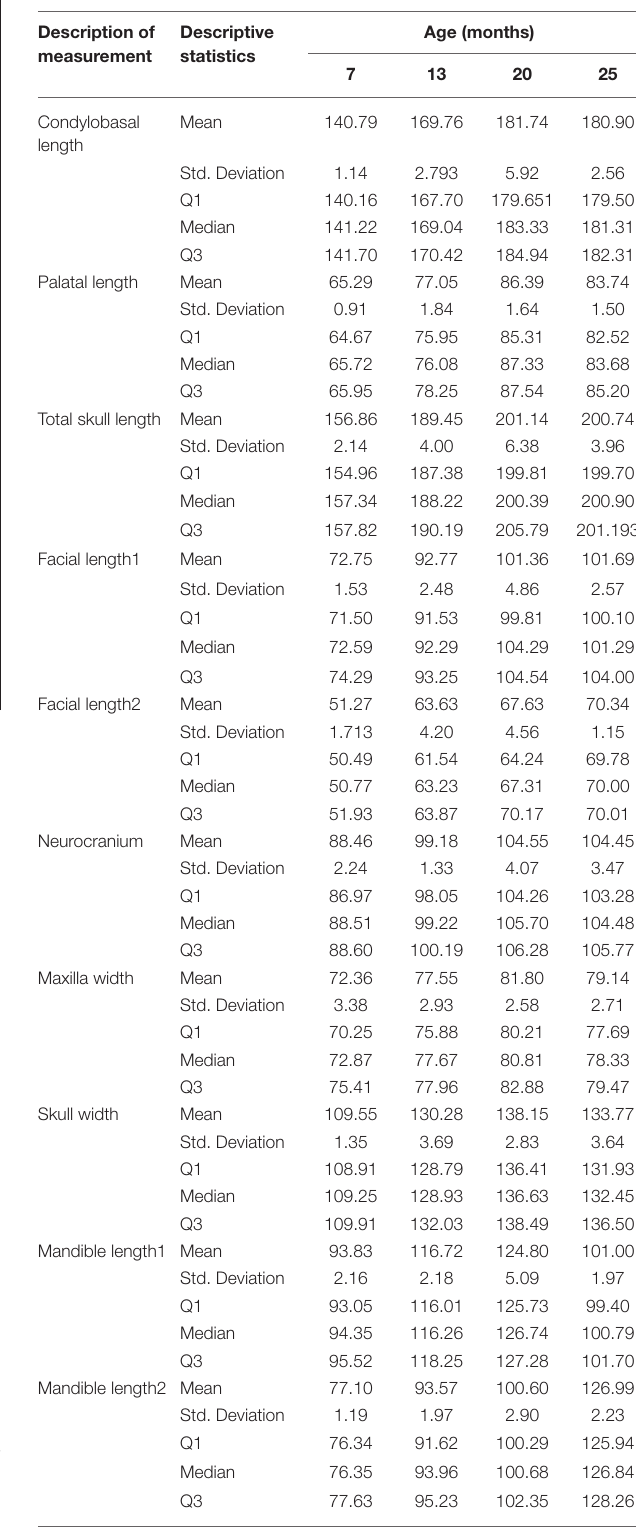
TABLE 4 | Presentation of the descriptive statistics for each of the 13 skull measurements for the five cheetah cubs at each age